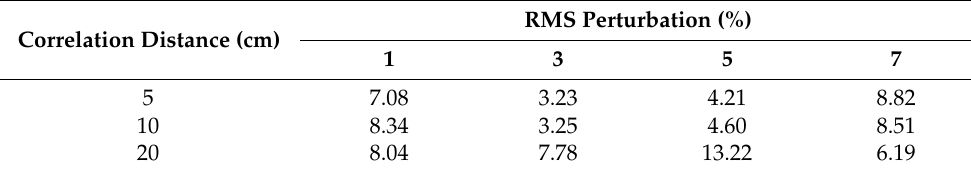
Table 2. Square errors between Yutu-2 LPR data and synthetic